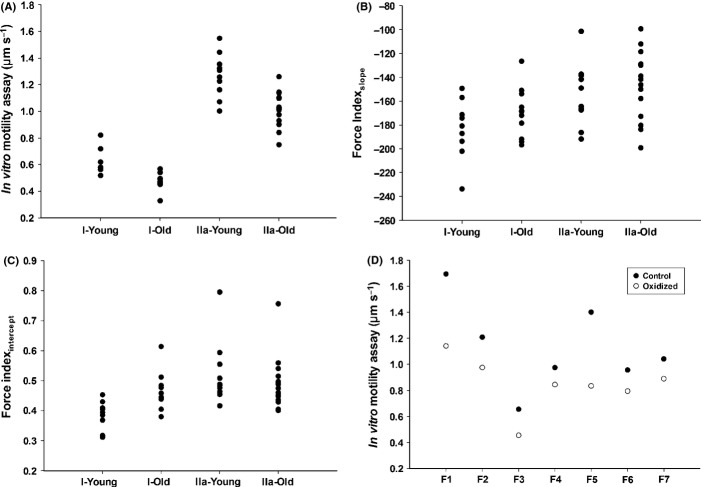
Myosin function The distribution of motility speed (A), force indexslope (B), and force indexintercept (C) of MyHC isoforms (type I and IIa) in young and old human muscle. The motility speed of the two halves of seven different single fibers (the oxidized and the control) (D).